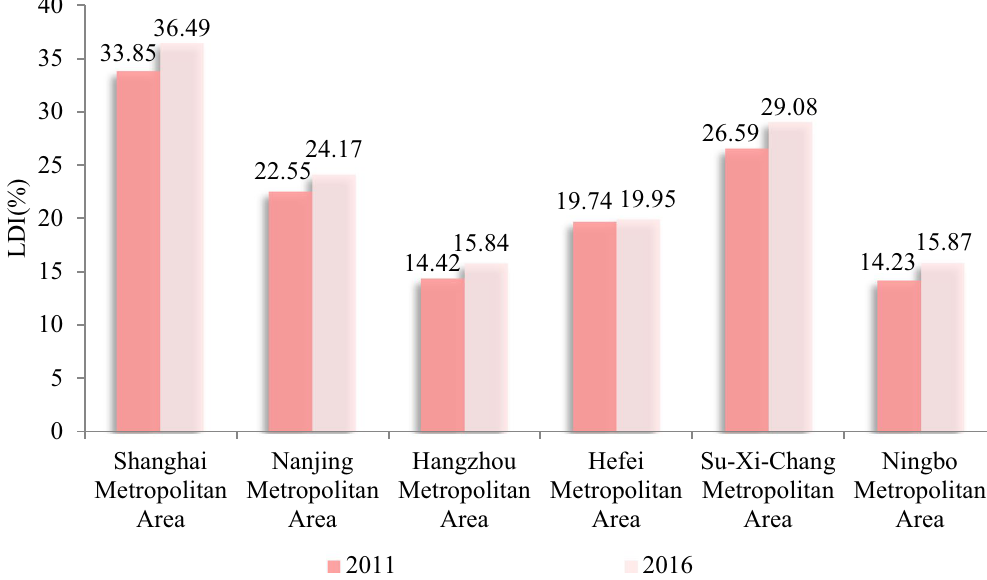
Figure 4. Changes in LDI in the metropolitan area of the YRD in 2011 and 2016. Software: Excel 2010. URL: https:// www. micro soft. com/ zh- cn/.